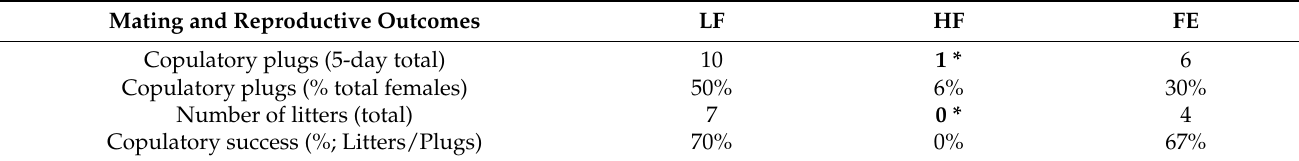
Table 2. Effect of multi-nutrient supplementation on mating behavior and reproductive outcomes in Western diet-fed C57BL/6J